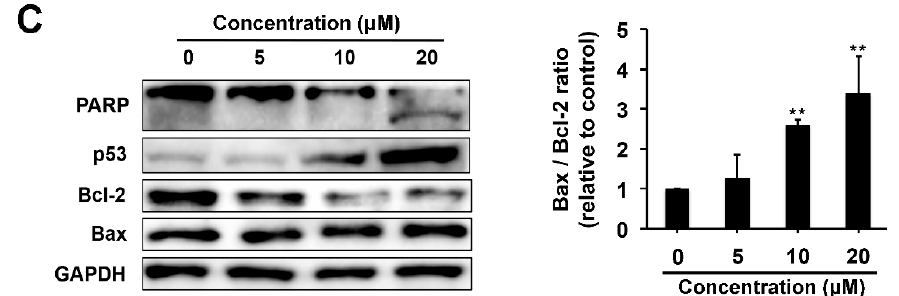
Figure 5. Compound 1 induced apoptosis in ovarian cancer cells. A2780 cells were treated with indicated concentrations of compound 1 for 24 h. ( A ) Apoptotic body of A2780 cells were detected by Hoechst 33342 staining; ( B ) Percentage of apoptotic cells was analyzed with Annexin V/PI assay; ( C ) Protein levels of PARP, p53, Bcl-2 and Bax were determined by western blot analysis. The relative Bax/Bcl-2 ratio